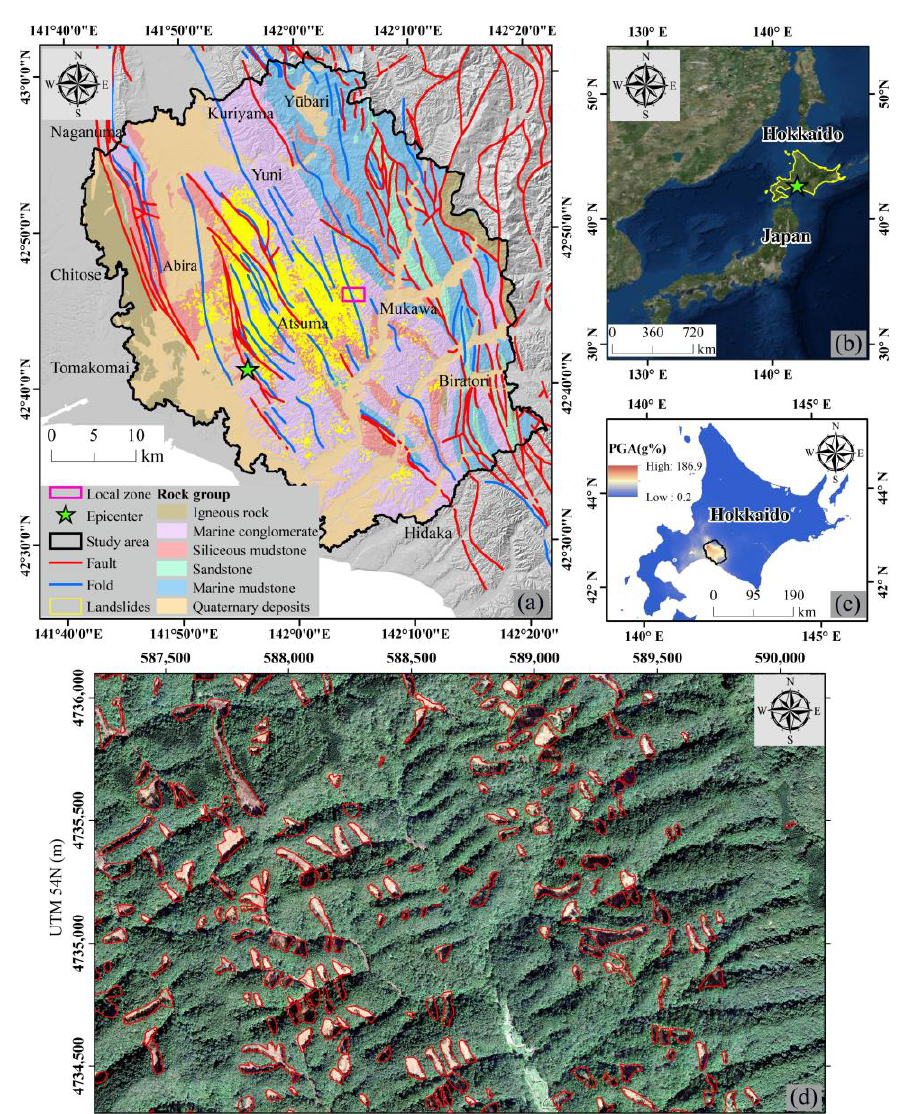
Figure 2. Overview map of the study area. ( a ) Geologic map at a scale of 1:200,000 overlain by the distribution of co-seismic landslides (source: geologic map in Table 1. The classification of rock groups has been modified.). ( b ) The locations and satellite imagery (source: http://goto.arcgisonline.com/maps/World_Imagery accessed on 1 September 2022) of the study area. ( c ) Distribution of peak ground acceleration in the Hokkaido region during the 6 September 2018, earthquake (source: QuiQuake in Table 1). ( d ) Satellite imagery (source: Maxar imagery acquired on 11 September 2018) of the co-seismic landslides in the local zone in ( a ). Table 1. Data set sources and meta-data.